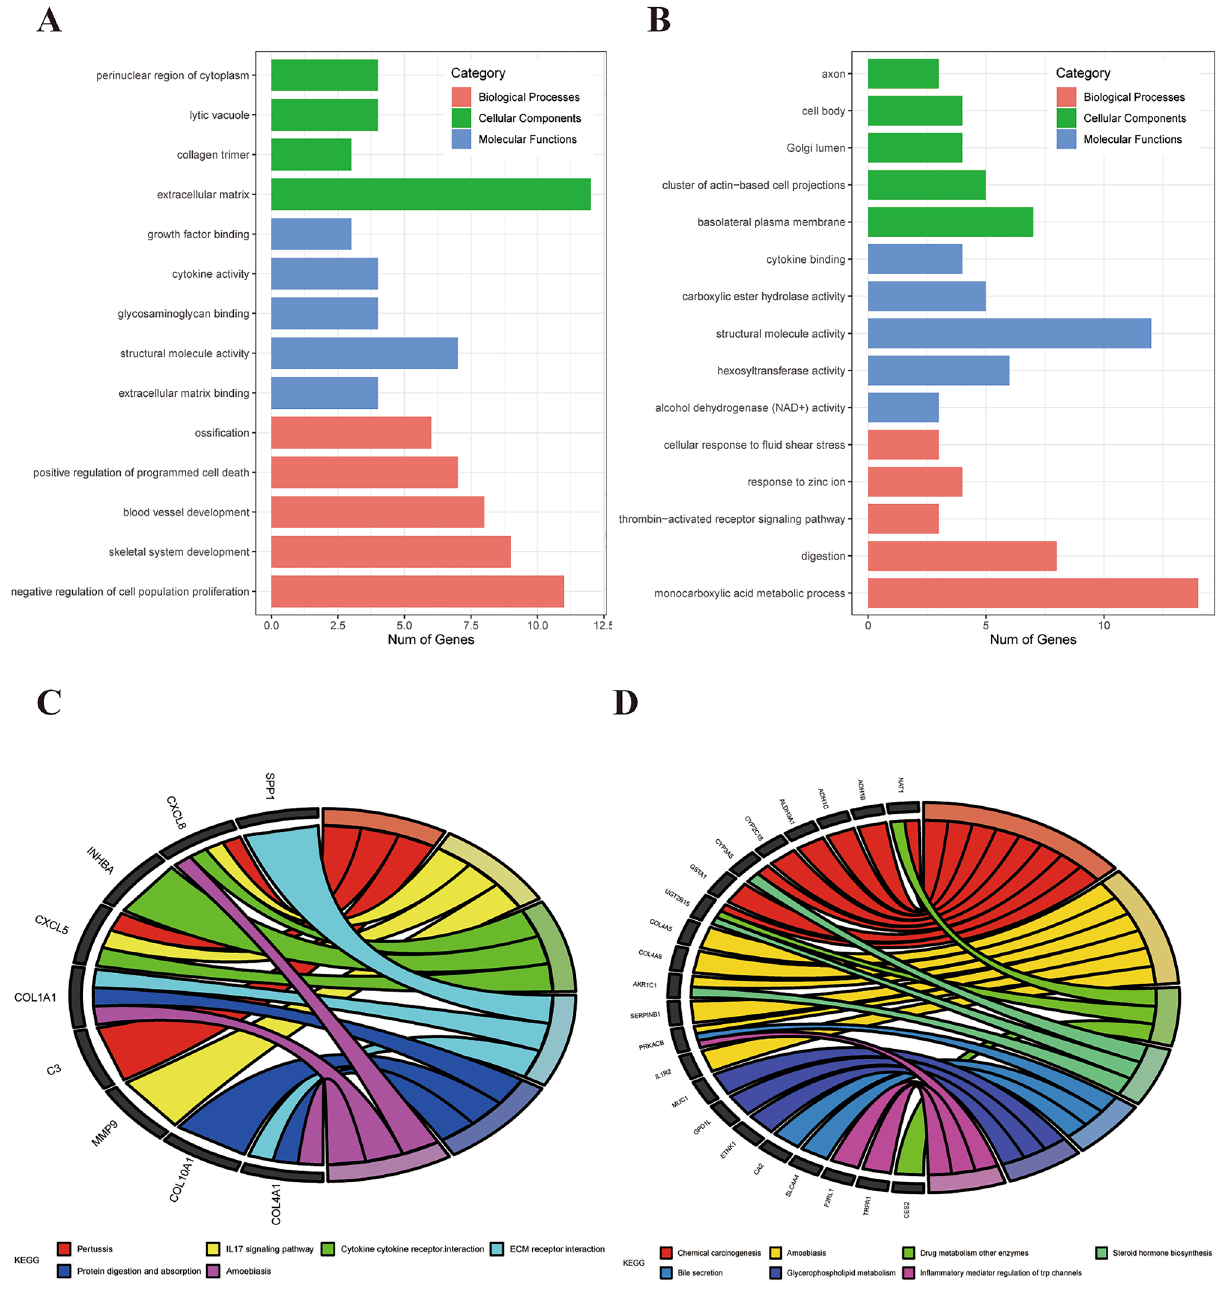
Figure 2. GO and KEGG pathway enrichment analysis. GO analysis of up ( A ) and down ( B ) regulated DEGs in EAC; KEGG analysis of up ( C ) and down ( D ) regulated DEGs in (Fig. 3B). Similar module clustering was constructed by using dynamic hybrid cutting (threshold = 0.25). A total of 25 modules were identified (Fig. 3C). The results in Fig. 3D showed that the grey module was the high- est positive module correlated to EAC (R 2 = 0.86, P = 2e −12 ) and was highly negative correlated to BE (R 2 = 0.86, P = 2e −12 ). Figure 3E showed gene significance for BE and EAC in grey module. In the module-trait analysis, we intersected the trait-related genes in grey module highly associated with EAC and 131 DEGs generated from expression difference analysis, and finally extracted 27 trait-expression-related genes for the following analysis (Fig. 3F, Tables S1 and S2). These results showed that the 27 trait-expression- related genes were significantly correlated with the pathogenesis of EAC. Exploration of trait-expression-related genes in TCGA database. Next, further validation and exploration were conducted among the 27 trait-expression-related genes in TCGA database. MYO1A , ACE2 , COL1A1 , LGALS4 , and ADRA2A were significantly up-regulated in EAC tissue; while AADAC , RAB27A , and